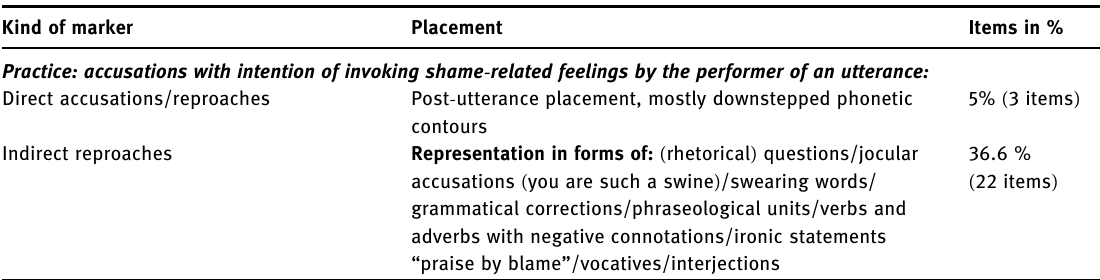
Representation in forms of: ( rhetorical ) questions/jocular accusations ( you are such a swine ) /swearing